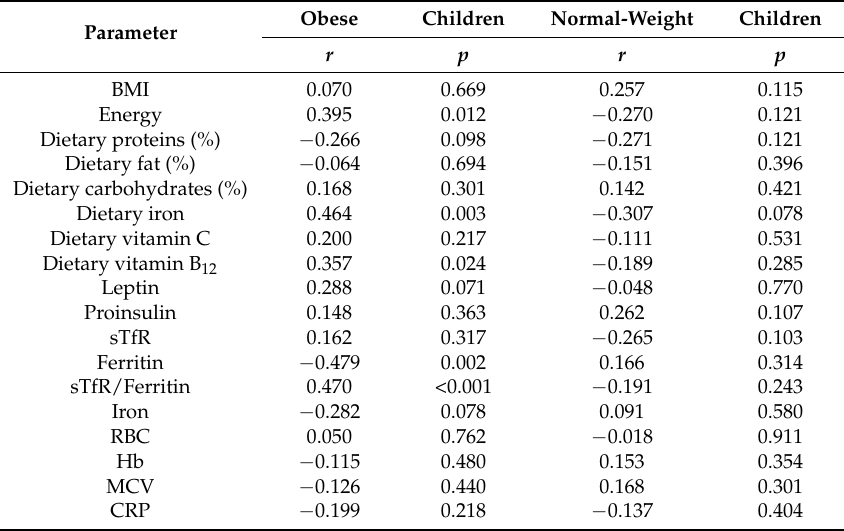
Table 7. Correlation analyses of the ferroportin/hepcidin ratio with clinical, nutritional data and iron status parameters in the obese and normal-weight groups. Parameter